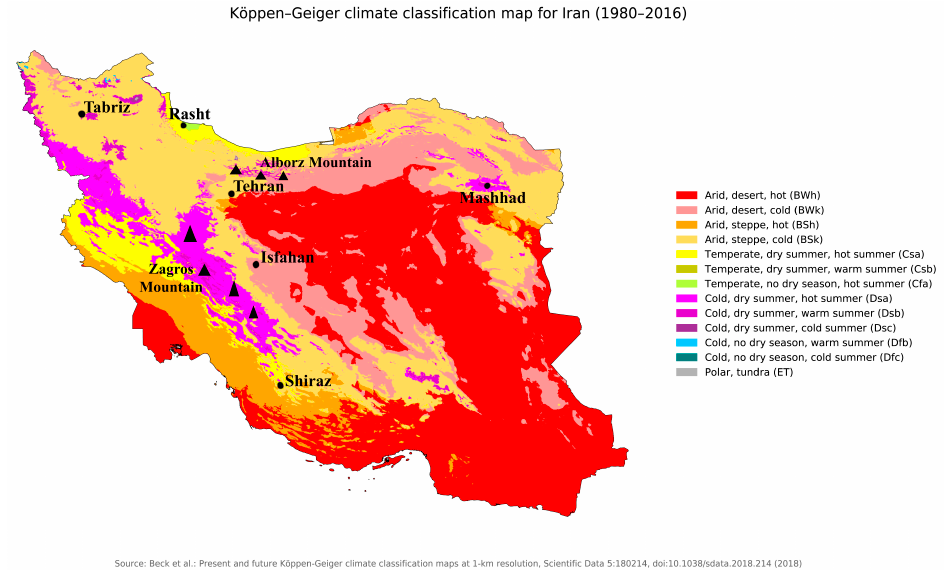
Figure 1. Köppen-Geiger climate classification map of Iran, with studied locations and mountainous areas.